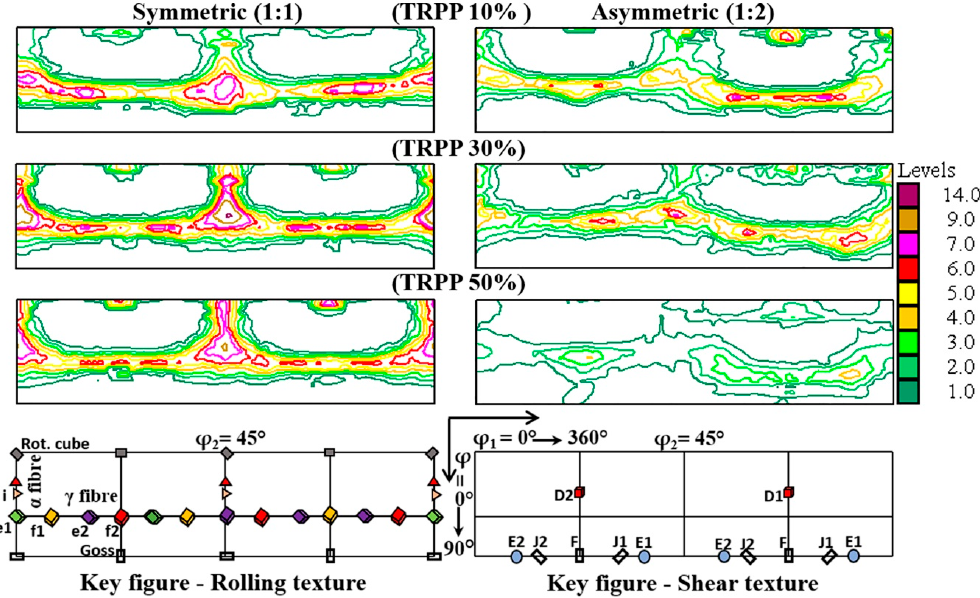
Figure 3. φ 2 = 45° ODF sections at mid ‐ thickness for symmetric (1:1) and asymmetric (1:2) rolling in medium strain range (75%) with TRPP of 10, 30, and 50%.